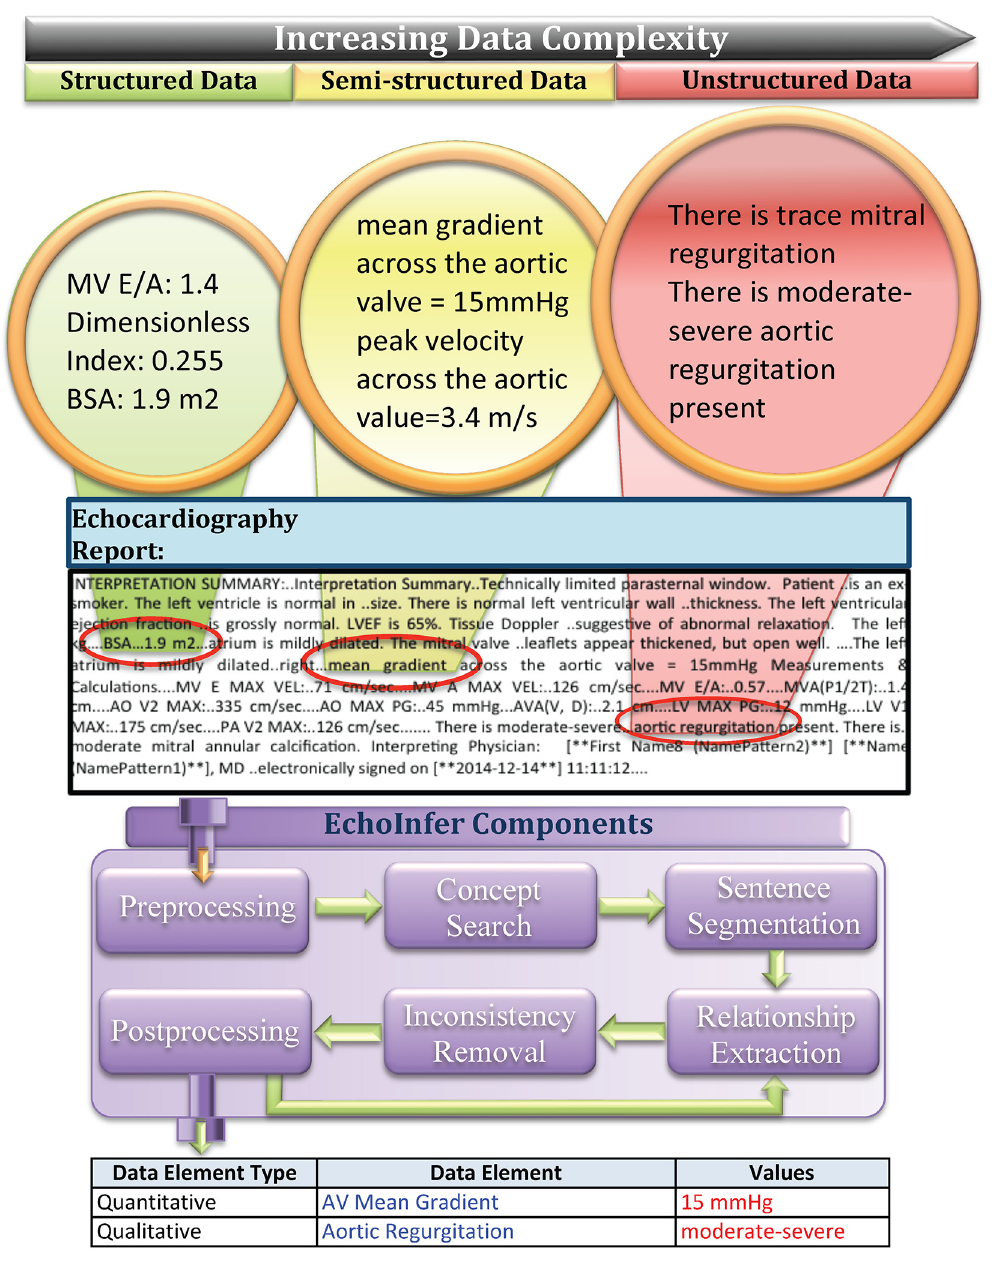
Fig 1. Extraction of data elements and values into structured format from structured, semi-structured, and unstructured data from echocardiography reports.